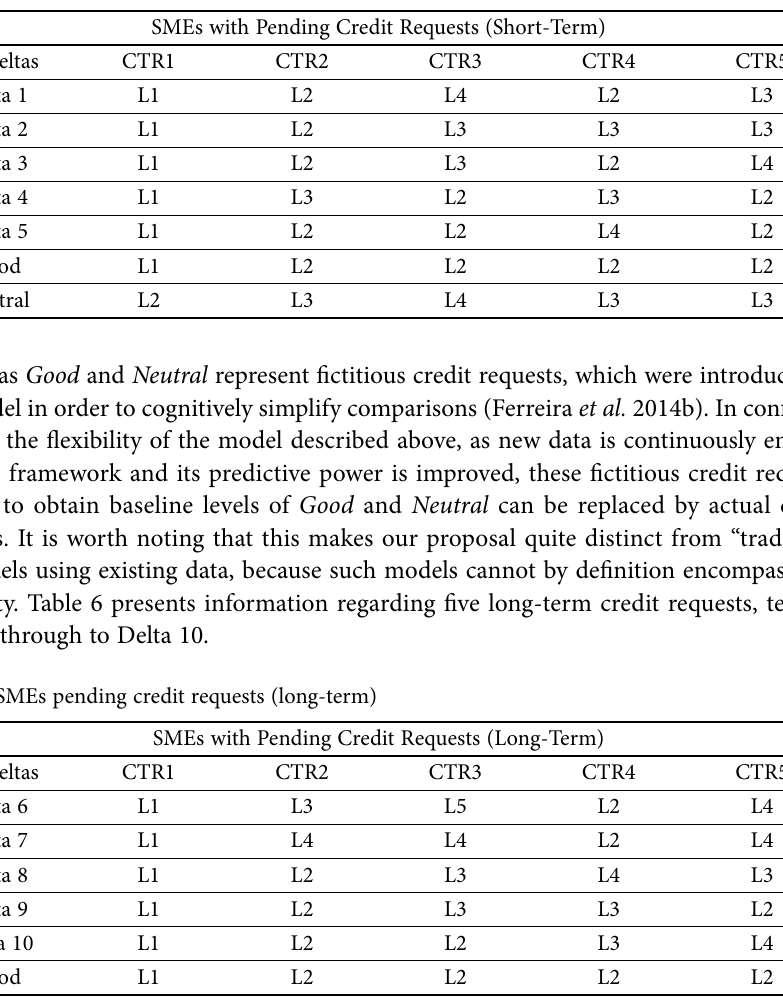
Table 5. SMEs with pending credit requests (short-term)